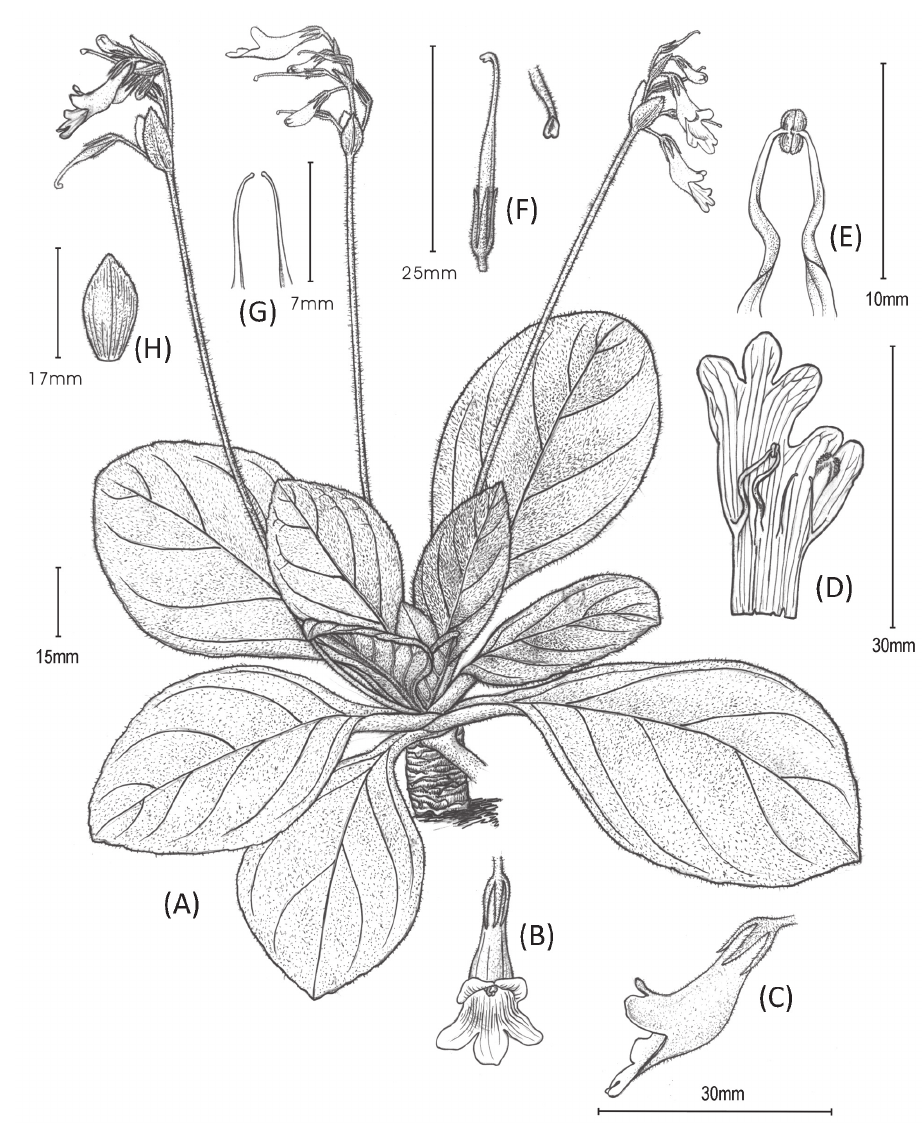
Figure 1. Primulina malipoensis . A habit B flower in front view C flower in side view D opened corolla, showing stamens and staminodes E fertile stamens F pistil and stigma G staminodes H bract. Drawn by Yun-Xiao Liu based on a cultivated individual collected from type